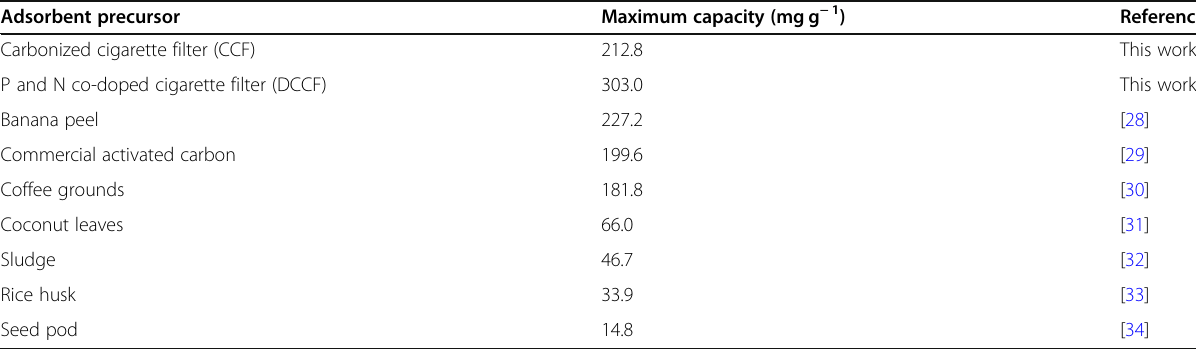
Table 4 Comparison of maximum adsorption capacity of MB of CCF and DCCF to other adsorbent materials (at 298 K) Adsorbent